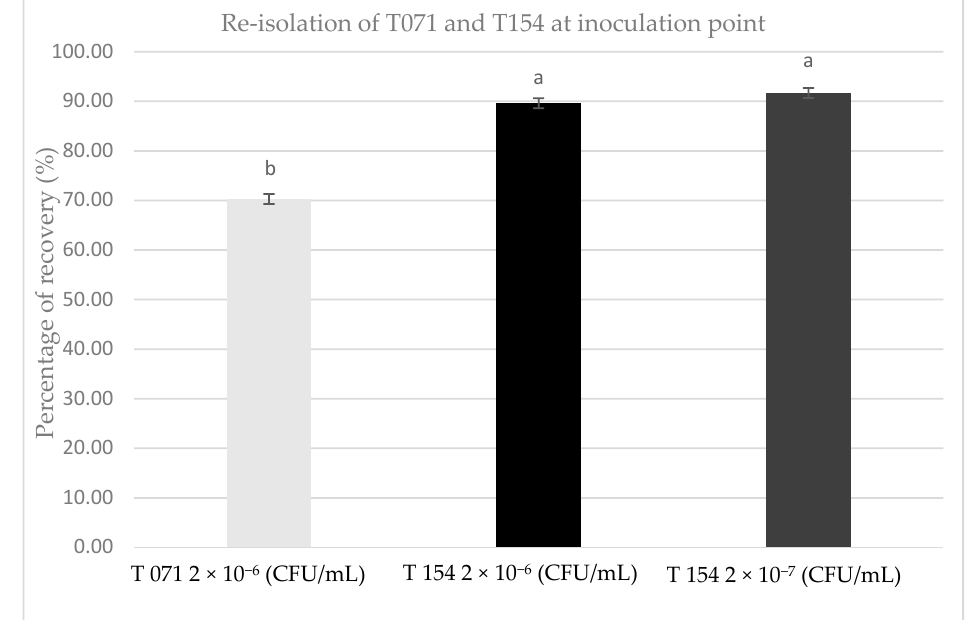
Figure 7. Percentage of re-isolation of pruning wounds after 12 weeks applying Trichoderma strain from T071 and T154. Values followed by the same letter do not differ significantly ( p = 0.05). Trichoderma strains were recovered 3 cm above the inoculation point in one of the eight vines for both of the strains. However, below the inoculation points at 6, 9, 12, and 15 cm, it was not possible to re-isolate Trichoderma .